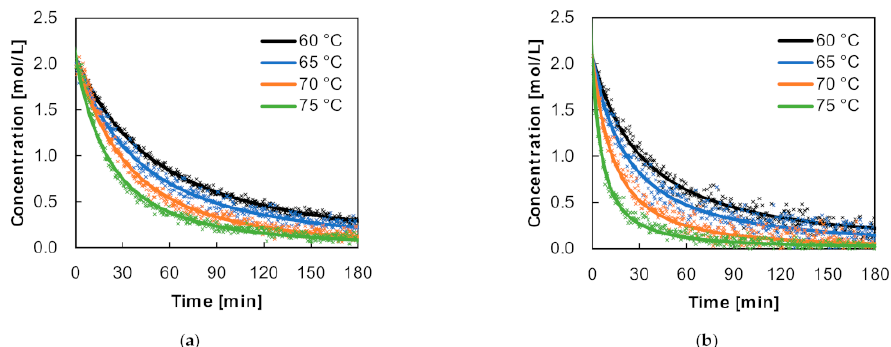
Figure 4. Concentration profiles of acrylic acid polymerisations in isopropyl alcohol (150 g/L) initiated with AIBN: 0.5 mol% ( a ), and 1.0 mol% ( b ). Crosses denote the normalised integral of the C=C stretching vibration band acquired by Raman spectroscopy, multiplied by the initial acrylic acid concentration. Solid lines are fitted according to n -th order kinetics.